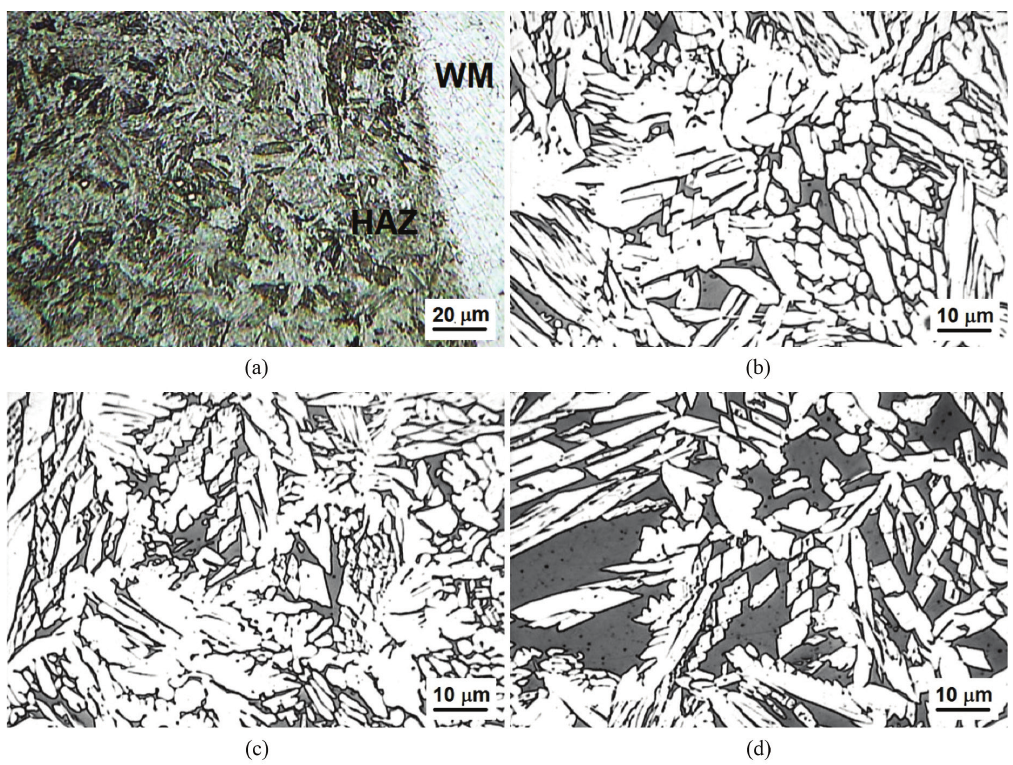
The chemical compositions of the three regions of the WRC-1992 diagram 12 (also shown in Table 2). Table 3 Figure 1 were determined by EDX in the scanning electron compares the predicted austenite fraction determined microscope (SEM). Carbon, nitrogen and sulfur were according to WRC-1992 diagram with the actual values determined by combustion with sparks from the root and last measured by quantitative metallography. The austenite pass. These elements could not be analyzed in the middle volume fraction measured by metallography is considerably region, but, as a rough approximation, they were considered higher than the prediction, mainly for the finish passes. The as the average of the root and last passes. Table 2 shows the root and the middle passes have more austenite than the last estimated chemical compositions of the three regions. From and Ni were calculated according to these values the Cr passes, probably due the higher Cr and Mo and lower Ni and eq. eq.